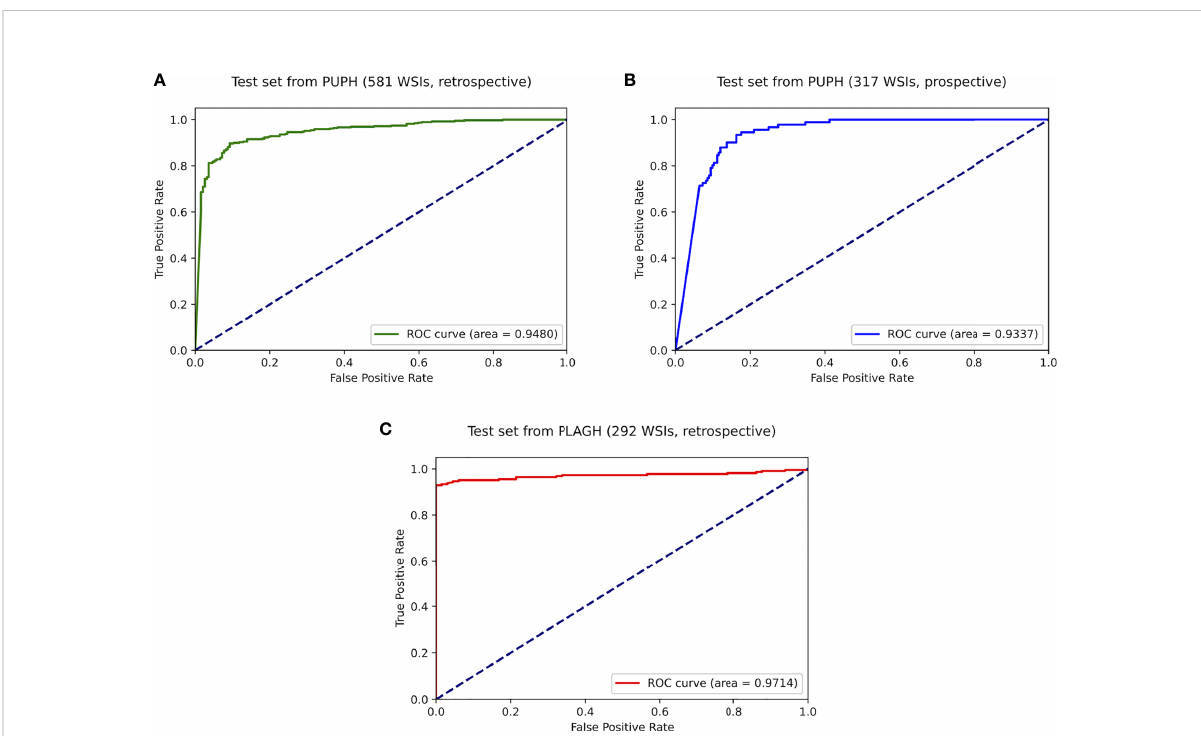
FIGURE 4 ROC curves of the best-trained model showed promising predictive power on the test datasets. (A) Retrospective test dataset from PUPH. (B) Prospective test dataset from PUPH. (C) Retrospective test dataset from PLAGH.